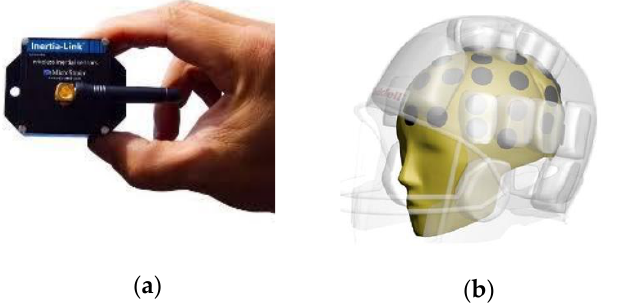
Figure 4. ( a ) Microstrain ® wireless inertial sensor; ( b ) Head Impact System with